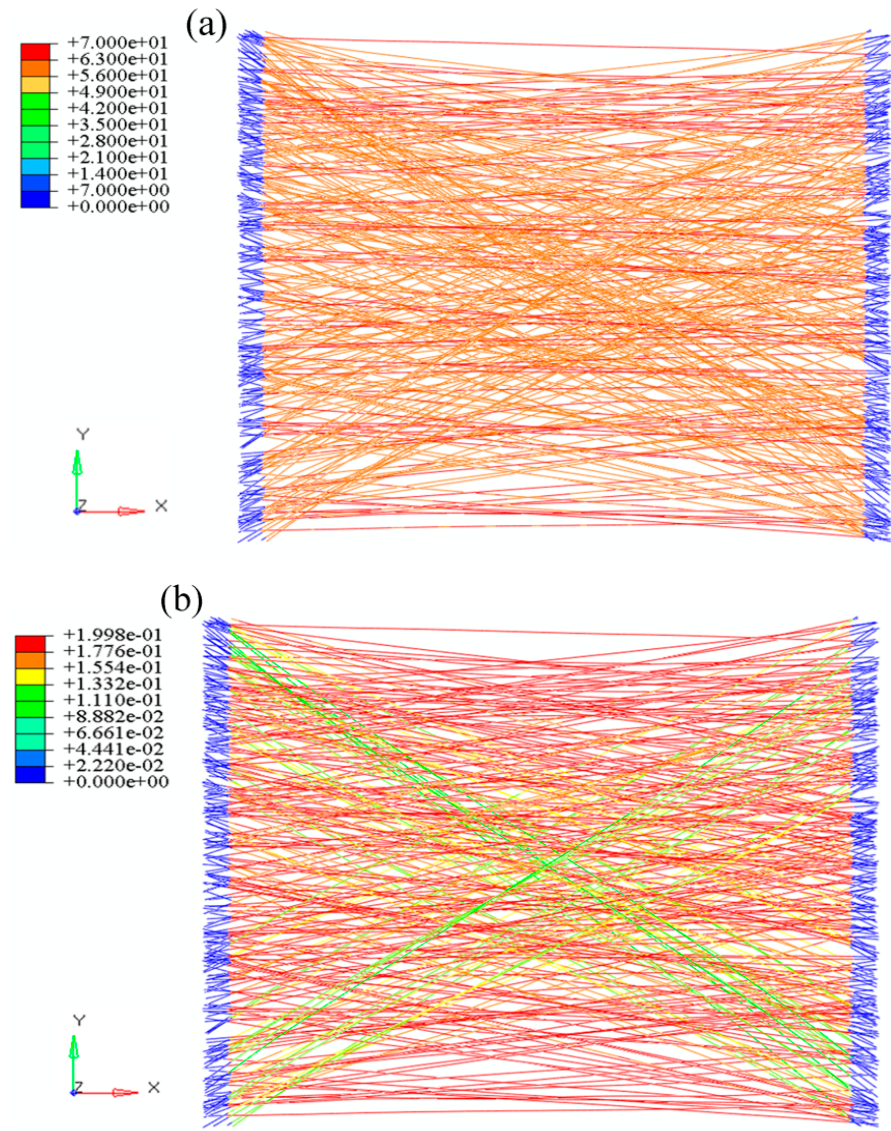
Figure 15. Tensile cloud image of nanofibrous mats. ( a ) stress (MPa); ( b ) strain.